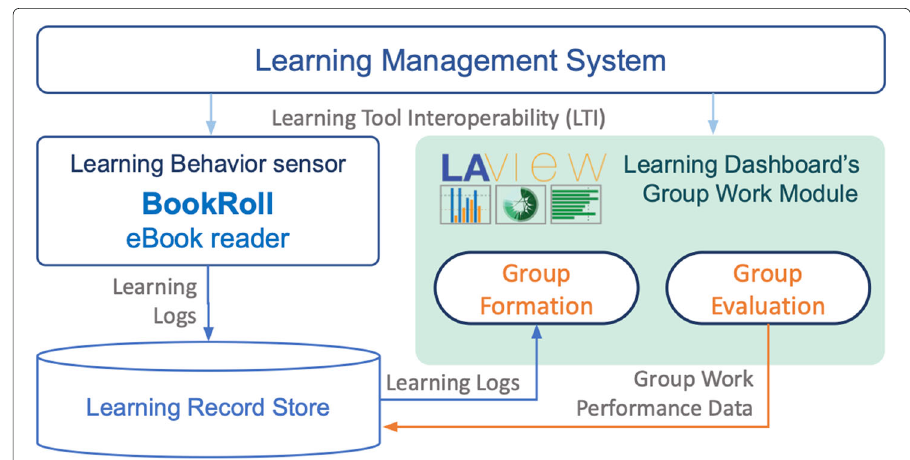
Fig. 2 Architecture of the learning analytics-enhanced group work